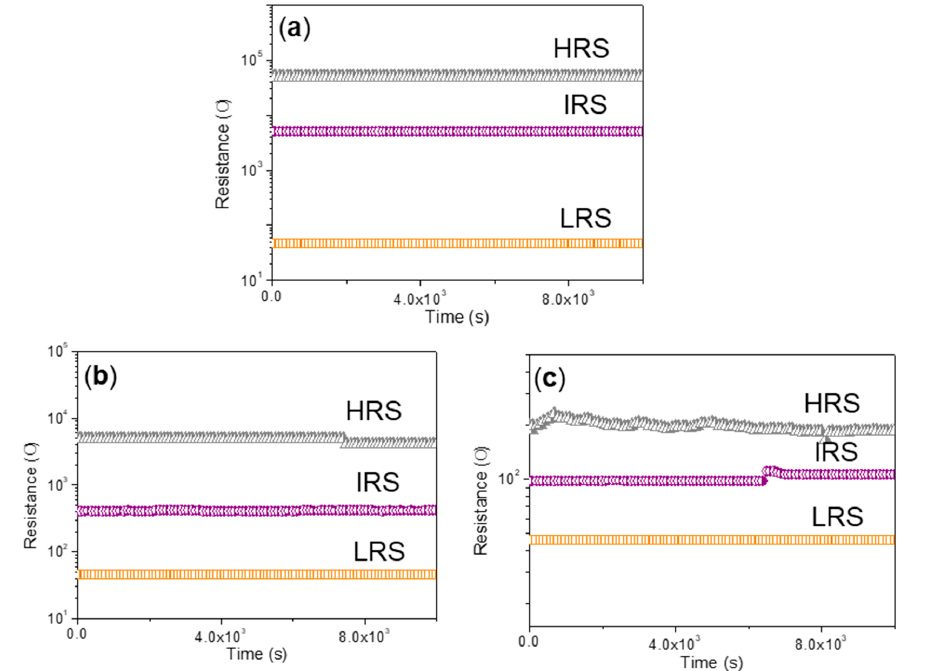
Figure 11. Retention characteristics of ITO/CS:GO/Ni devices based on CS-based blends with ( a ) 2:1, ( b ) 5:1, and ( c ) 10:1 ( w / w ). The resistance value was read at − 0.1 V during the retention time and was investigated under ambient condition.